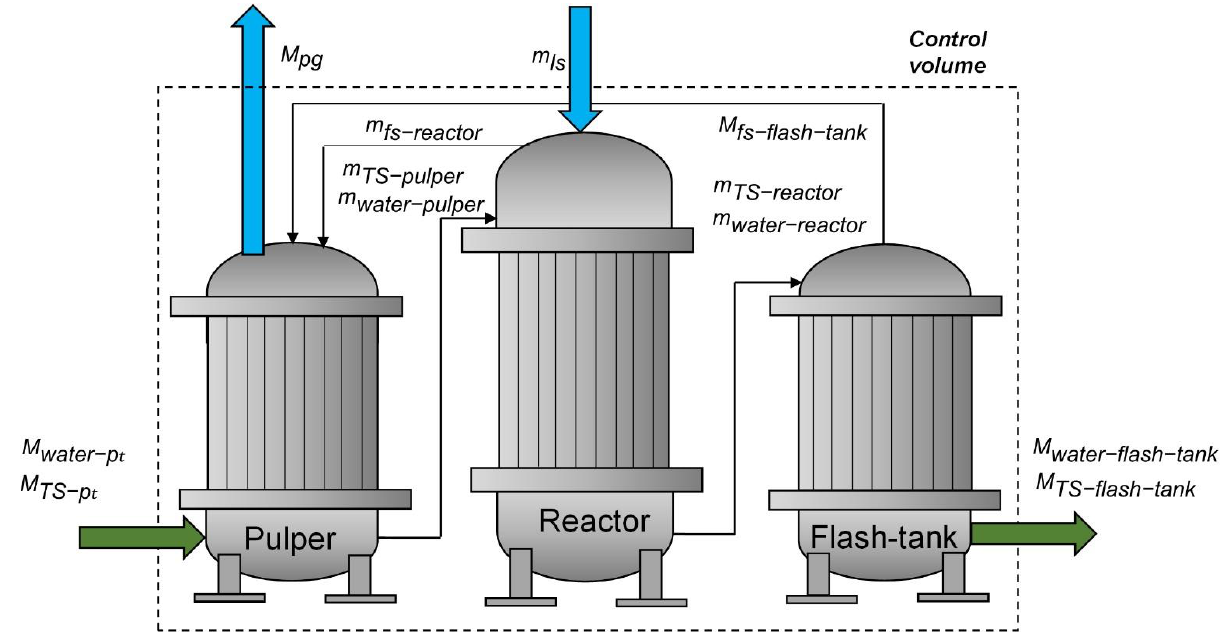
Figure 2. Cambi THP diagram, representing the nomenclature used for performing the calculations. The average cycle is